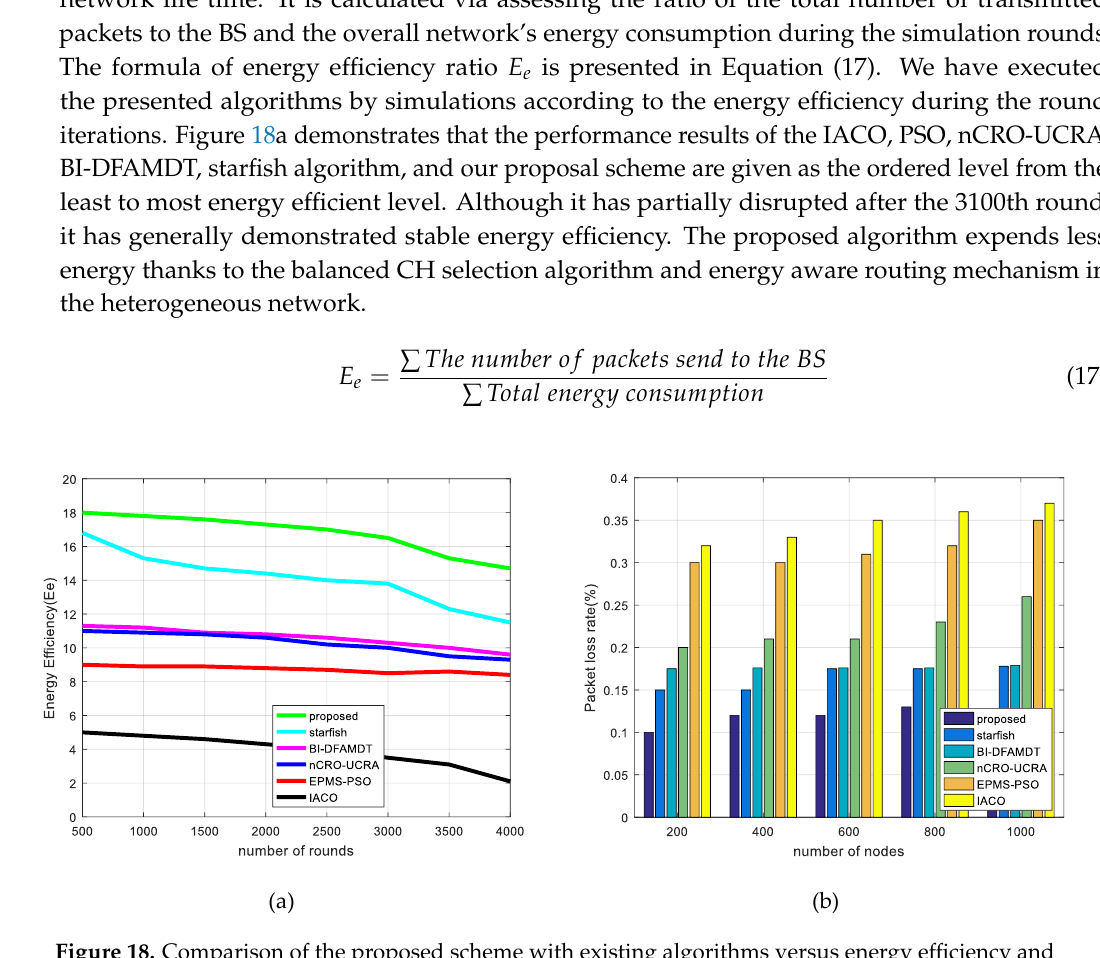
Figure 18. Comparison of the proposed scheme with existing algorithms versus energy efficiency and packet loss rate results: ( a ) Energy efficiency; and, ( b ) Packet loss rate.